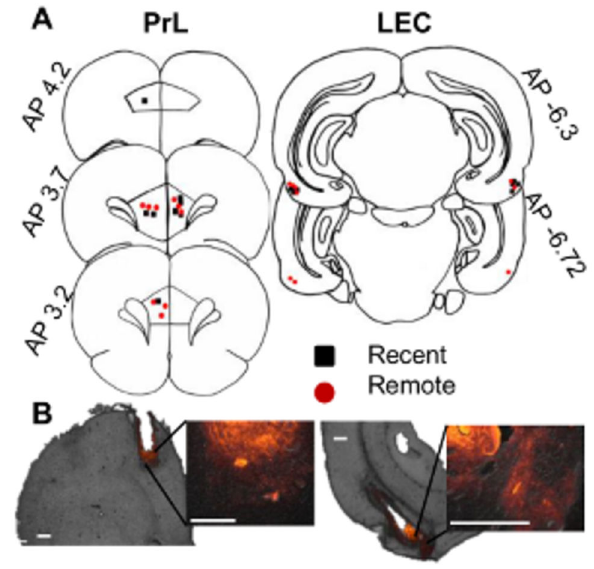
Figure 1. Cannulae locations and muscimol spread in the prefrontal cortex and lateral entorhinal cortex. A , The rats whose cannulae tips were located in the prelimbic area of the medial prefrontal cortex (PrL; left) and lateral entorhinal cortex (LEC; right) were included in the behavioral analyses (Recent group, black; Remote group, red). The hemisphere that was implanted with a cannula was counterbalanced across rats. B , The spread of muscimol was estimated with muscimol tagged to a fluorescent molecule (red). The spread was mostly restricted to the PrL (right) or LEC (left). The inset images show magnified views of each infusion site. Scale bars indicate 500